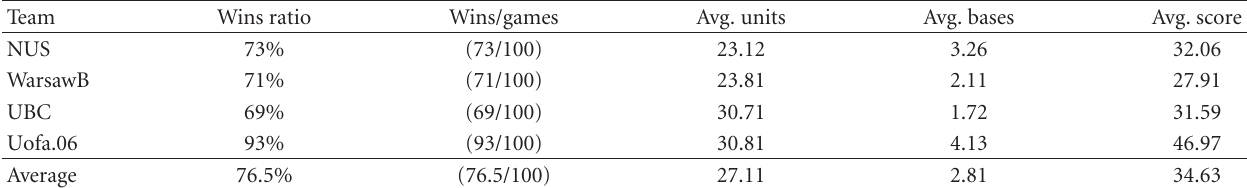
Table 5: Experiment results from avoid-past potential field forces.